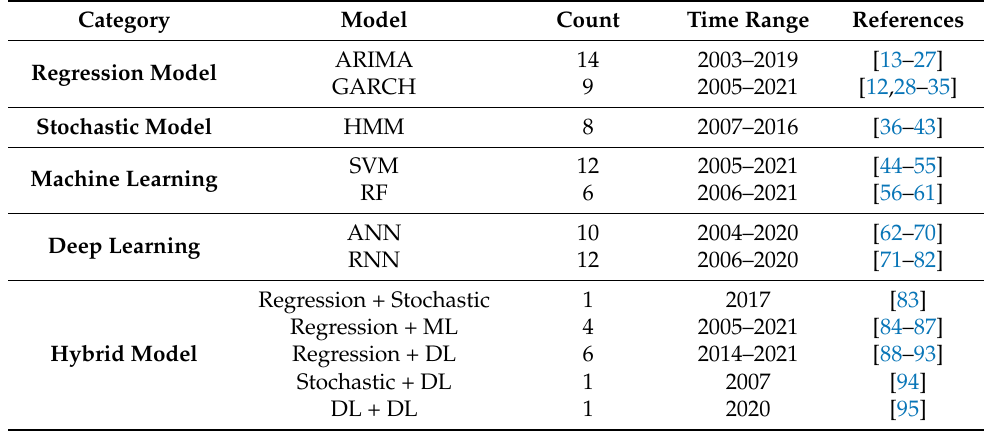
Table 1. Review on time-series forecasting studies for dynamic pricing from 2001 to